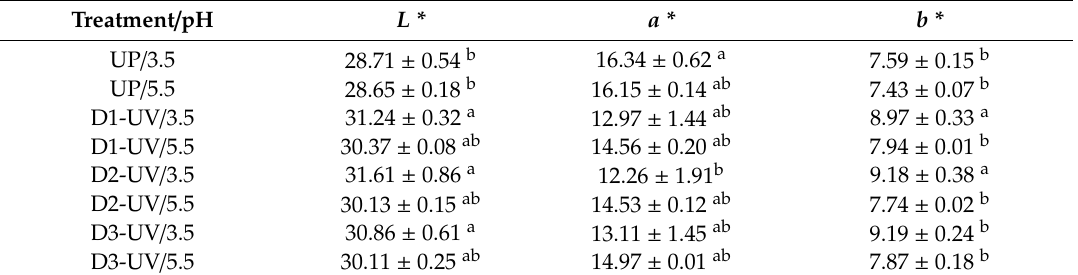
Table 2. E ff ects of the UV-C radiation and pH on color parameters of Aloe vera– pitaya blends. Treatment /